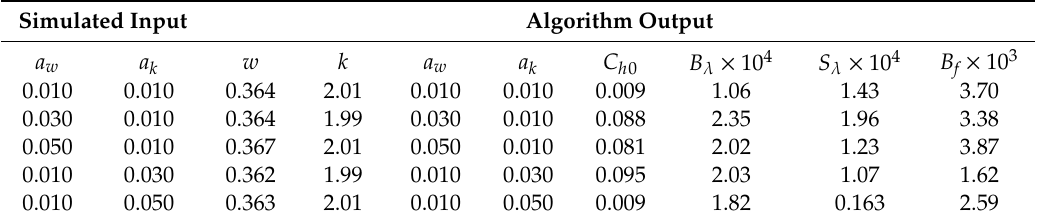
Table 7. Sensitivity results of the algorithm with changes of asymmetries (a w and a k ) in the simulated input